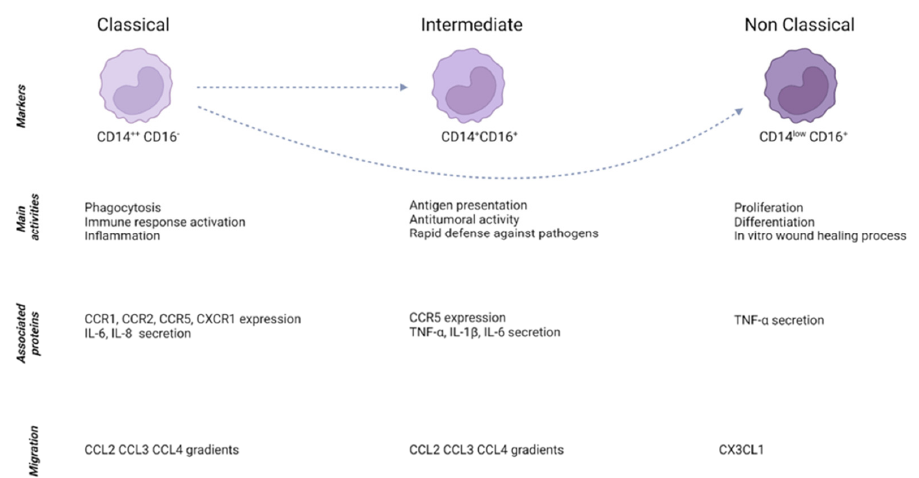
Figure 1. Traditional classification of monocytes . Traditionally, monocytes are classified as classical, intermediate and non ‐ classical. Intermediate and non ‐ classical monocytes can differentiate from the intermediate and non-classical. Intermediate and non-classical monocytes can differentiate from the classical subset. The figure shows markers, molecules and activities of each subset. classical subset. The figure shows markers, molecules and activities of each In cancer, monocytes are key regulators of tumorigenesis and tumor progression [22].